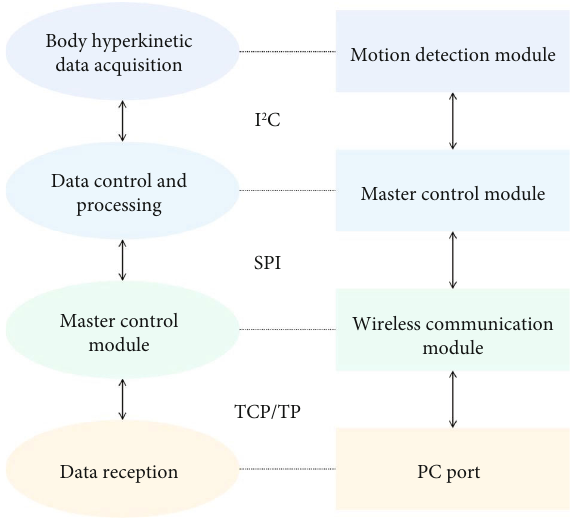
Figure 2: System hardware